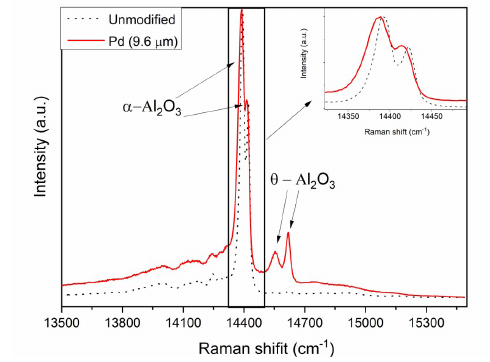
O oxide scale formed 2 3